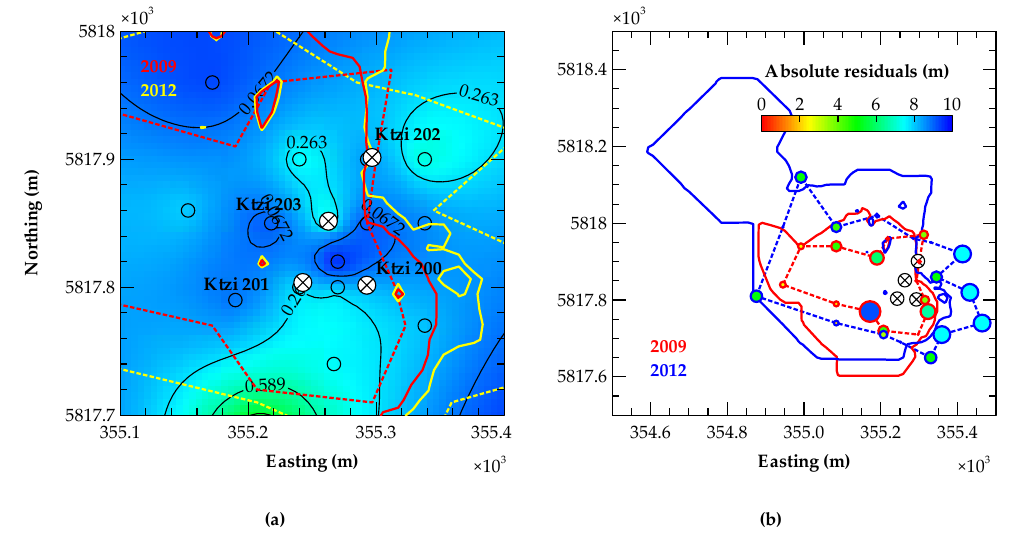
Figure 7. ( a ) Close-up plan view of gaseous CO 2 extent detected by 3D seismics in 2009 (detection threshold 5 m, red dashed line) and 2012 (detection threshold 7.5 m, yellow dashed line), and simulated gaseous CO 2 thickness contours for 2009 (5 m thickness, solid red line) and 2012 (7.5 m thickness, solid yellow line). Empty circles represent pilot points, white-filled circles with crosses well locations. Blue-to-red contours show the permeability multipliers determined by inverse model calibration. ( b ) Close-up plan view of absolute thickness residuals based on the data provided in Figure 6b. Circles are scaled to absolute residuals at their respective locations (UTM-WGS84